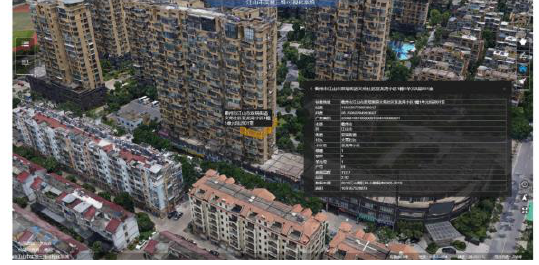
Figure 4 . The 3D Real Scene of Jiangshan City.